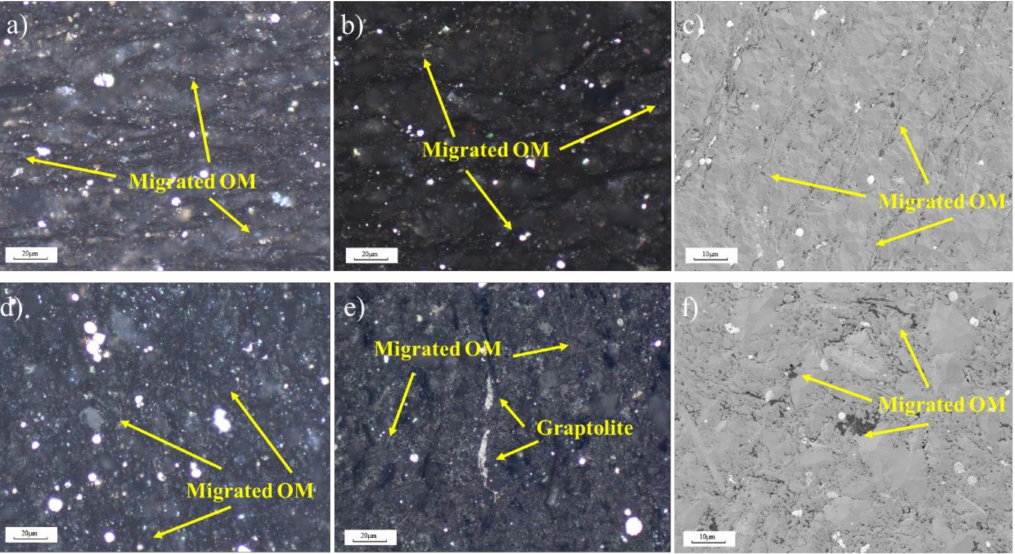
Figure 2. Morphological features of OM in marine shale. ( a , b ) in Lower Silurian shale, the OM occurs in an amorphous state that appears light-gray under white light (L1 and L2); ( c ) in lower Silurian shale, liptinite occur in fibrous or nodular shapes under FIB-SEM (L3); ( d , e ) in lower Cambrian shale, the OM occurs in an amorphous state that appears light-gray under white light (N3 and N4); ( f ) in lower Cambrian shale, liptinite occur in fibrous or nodular shapes under FIB-SEM (N4).